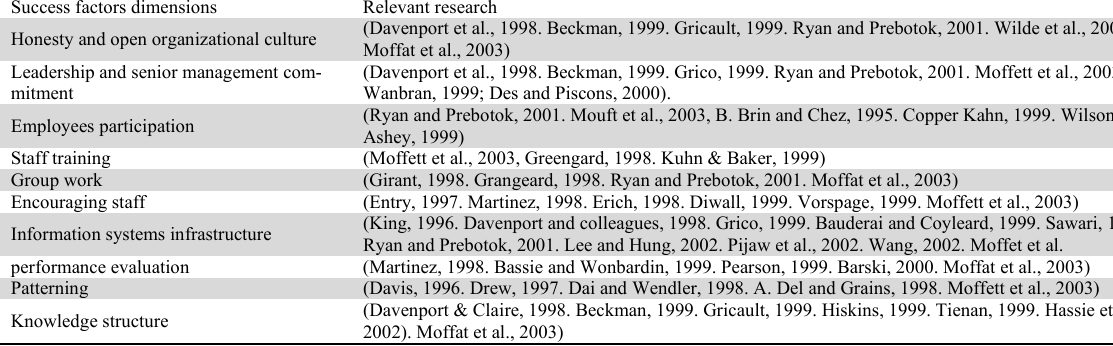
Classification of Knowledge Management Success Factors (Hung et al.,